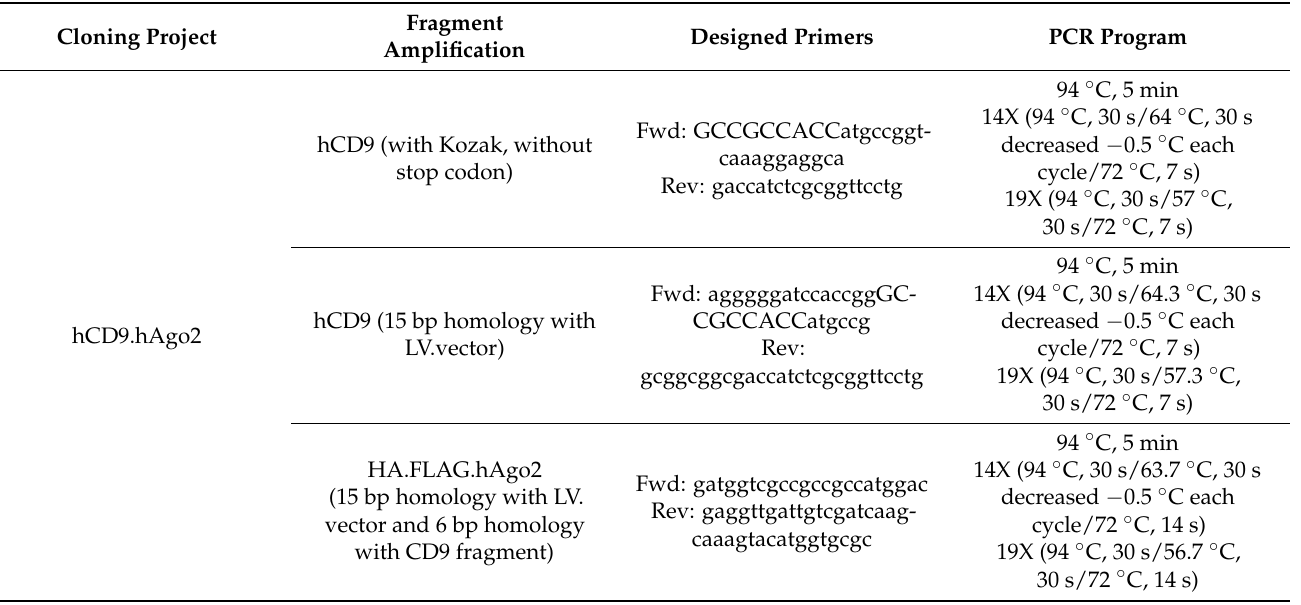
Table 1. The list of designed In-Fusion PCR primers by SnapGene and touch down PCR programs for fusion protein fragments